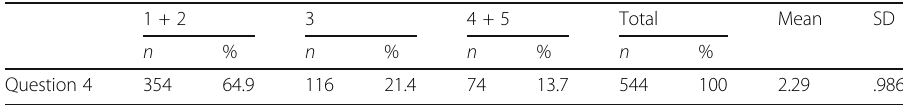
Table 8 Impact on students ’ English learning